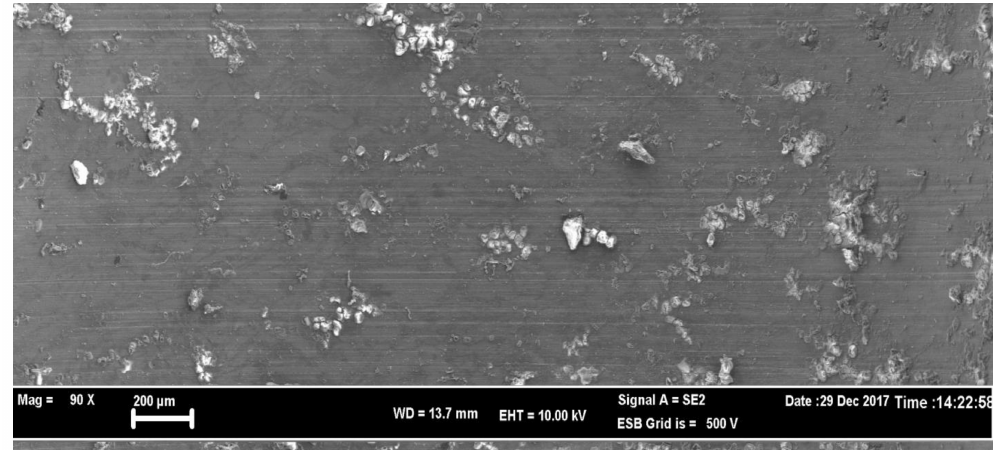
Figure 14. SEM image of the drilled surface at Vc = 30 m/min and f = 0.20 mm/rev when using the PVD-coated drill bit.